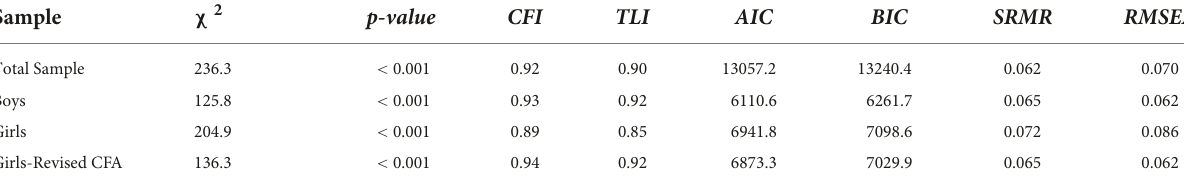
TABLE 3 CFA fit indices for the total analytic sample and by gender ( N = 579). Sample